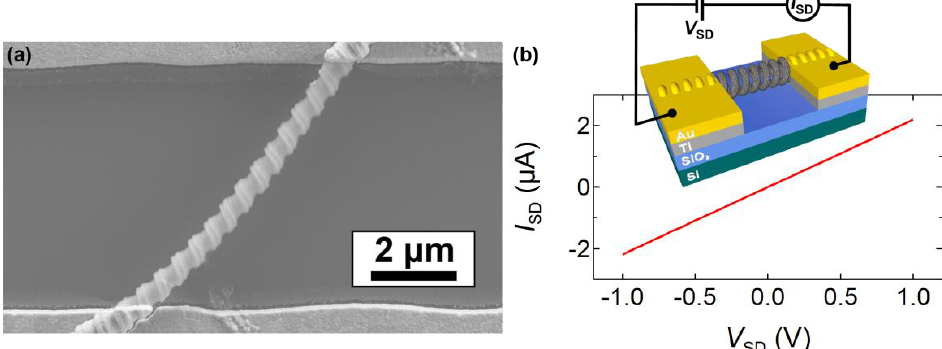
Figure 7. ( a ) SEM image of a single G-NS between two source – drain Ti/Au electrodes, and ( b ) the Ohmic I SD – V SD curve of a typical G-NS device and an inset showing a three-dimensional representation of the device and the corresponding electrical diagram.